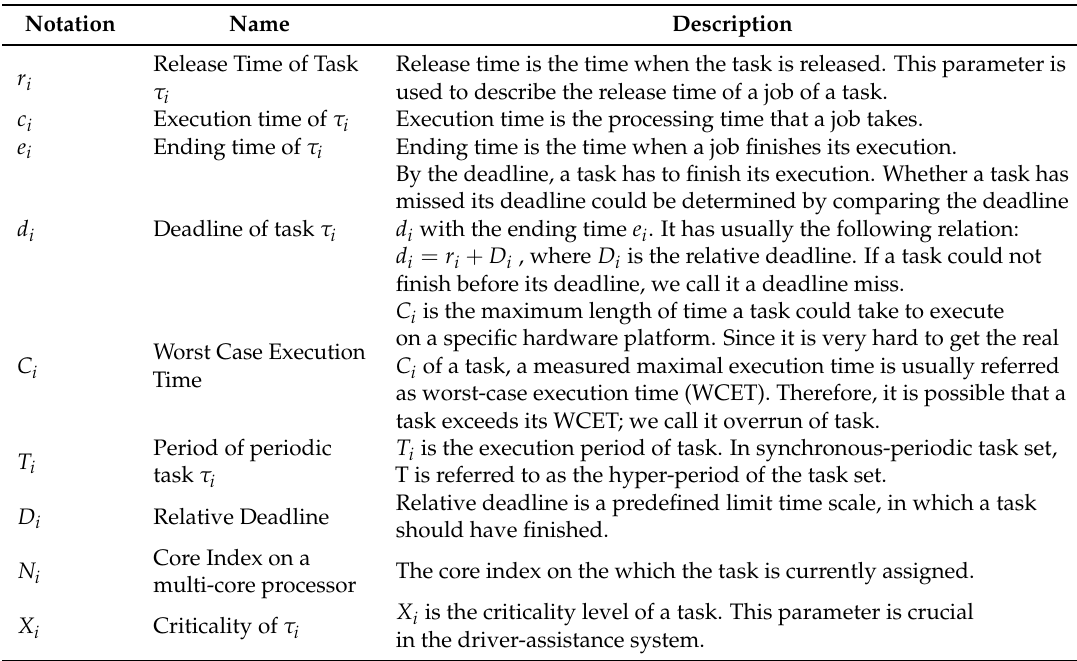
Table 2. Task characterisation in mixed-criticality EV